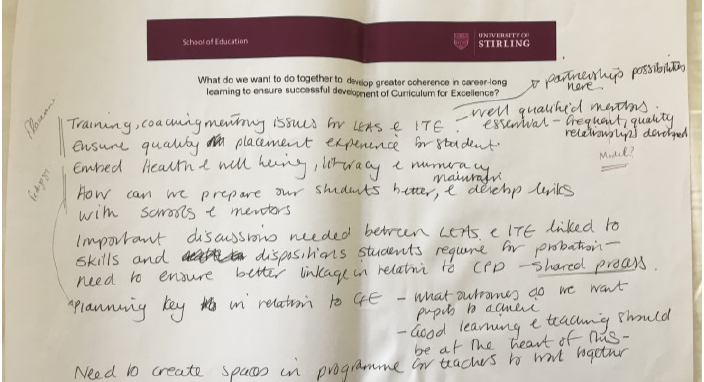
Figure 2. Artefact from seminar event, 16th May 2011. to the signature